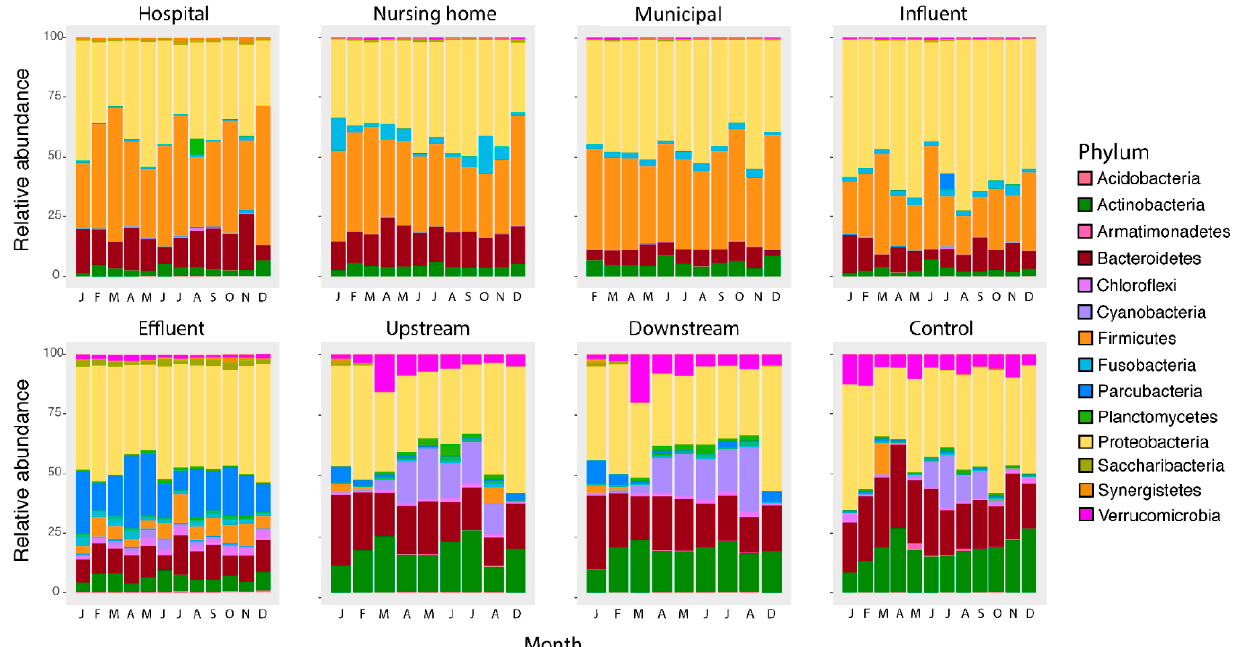
Figure 5. Relative abundance at the Phylum level per location per month. The main groups in wastewaters (hospital, nursing home, municipal wastewater and influent) consist of Proteobacteria, Firmicutes, Bacteroidetes and Actinobacter, which are significantly changed after the wastewater treatment with Proteobacteria and Parcubacteria as main groups in the effluent. Surface waters are similar to each other but form a distinct group dominated by Proteobacteria, followed by Actinobacteria and Bacteroidetes as the main